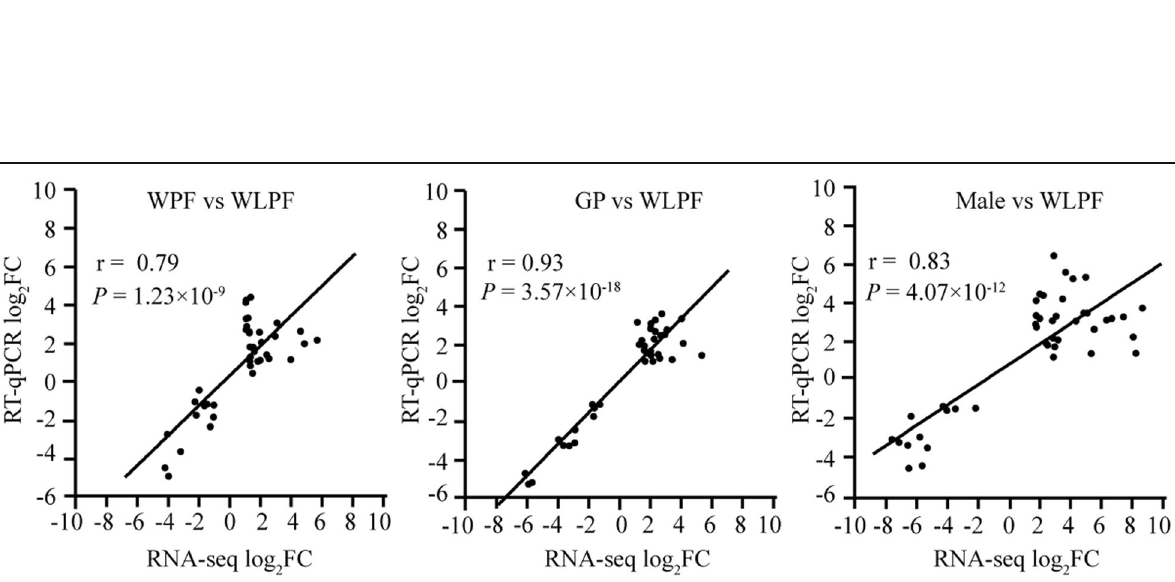
Fig. 5 Functional classification of KEGG pathways for the shared DEGs in the winged morphs. Compared with the wingless parthenogenetic female, all three-wing morphs showed 2 335 DEGs, including 1 658 upregulated and 677 down-regulated. The functional involvement of shared DEGs was analyzed using KEGG enrichment analysis, in which the shared upregulated and downregulated DEGs were enriched separately. The numerators and denominators of the fractions indicate the number of DEGs and the total number of genes in an enriched KEGG pathway, respectively. Significantly enriched pathways were determined at P < 0.05 in the hypergeometric test. A, endocrine system; B, carbohydrate metabolism; C, lipid metabolism; D, signal transduction; E, transcription; F, nucleotide metabolism. Up, upregulated; and Down,